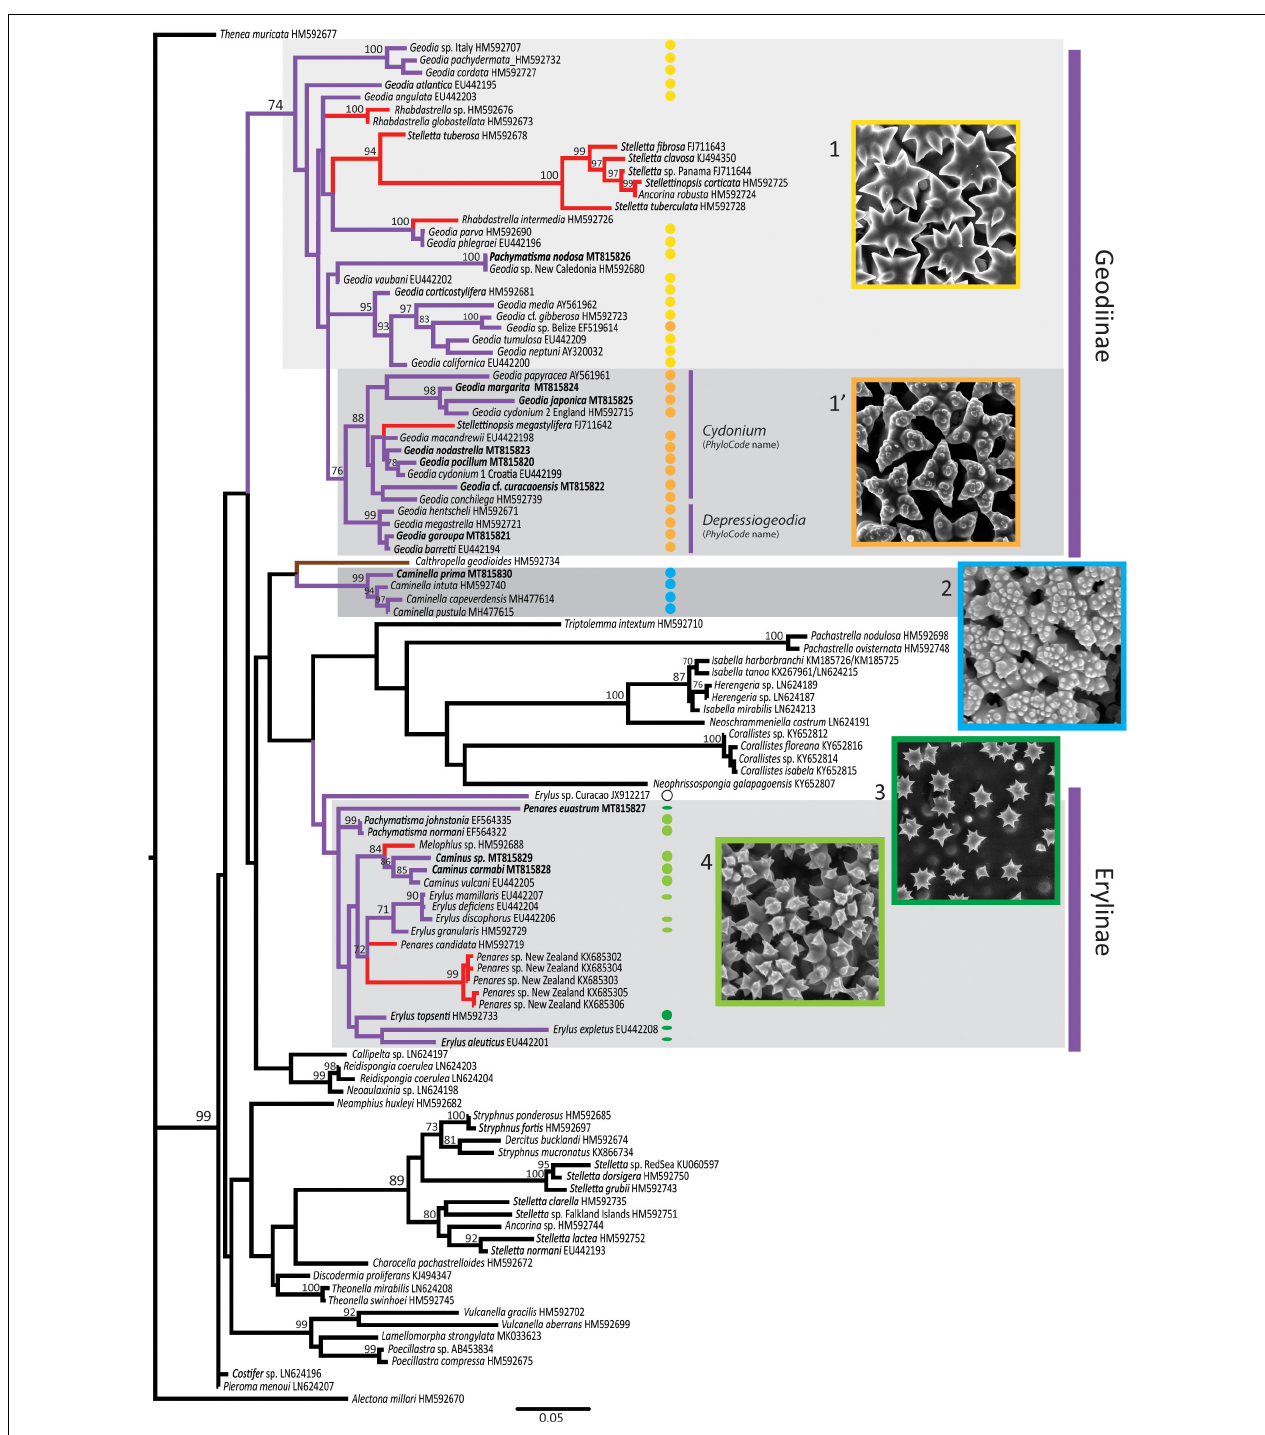
FIGURE 9 | Astrophorina COI maximum likelihood (ML) tree reconstructed with RAxML. ML bootstrap supports (1,000 bootstrap replicates) > 70 are indicated. Genbank accession numbers are given after each taxon. In bold are new sequences produced in this study. Geodiidae species have purple branches, Calthropellidae have brown branches. Red branches indicate Geodiidae species which secondarily lost sterrasters (species previously considered to belong to the Ancorinidae). Colored dots indicate sequenced species/specimens for which previous authors or this study have observed the surface of sterrasters with SEM (see Table 3 for references); round shapes represent sterrasters, flattened shapes represent aspidasters. Image inserts illustrate the five types of sterraster surfaces observed (1. smooth rosettes, in Geodia atlantica ; 1’. warty rosettes, in Geodia papyracea , holotype; 2. complex network, in Caminella pustula ; 3. clear single rosettes in Penares euastrum , holotype; 4. unclear rosettes in Pachymatisma normani ).